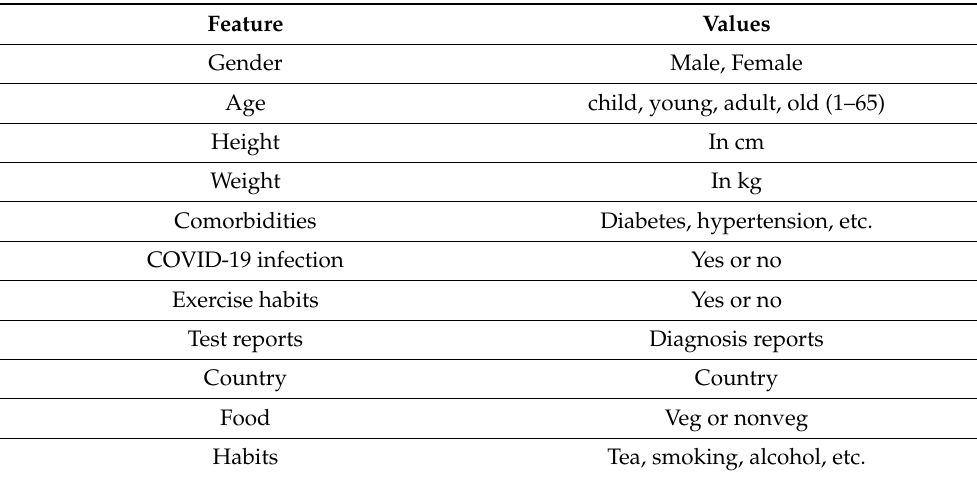
Table 1. Features of the lifestyle and health status of a